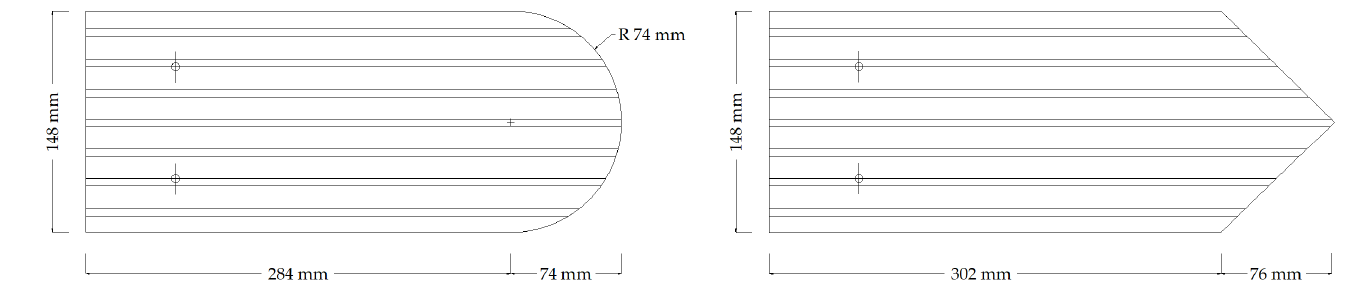
Figure 4. Geometry of historic roof tiles.